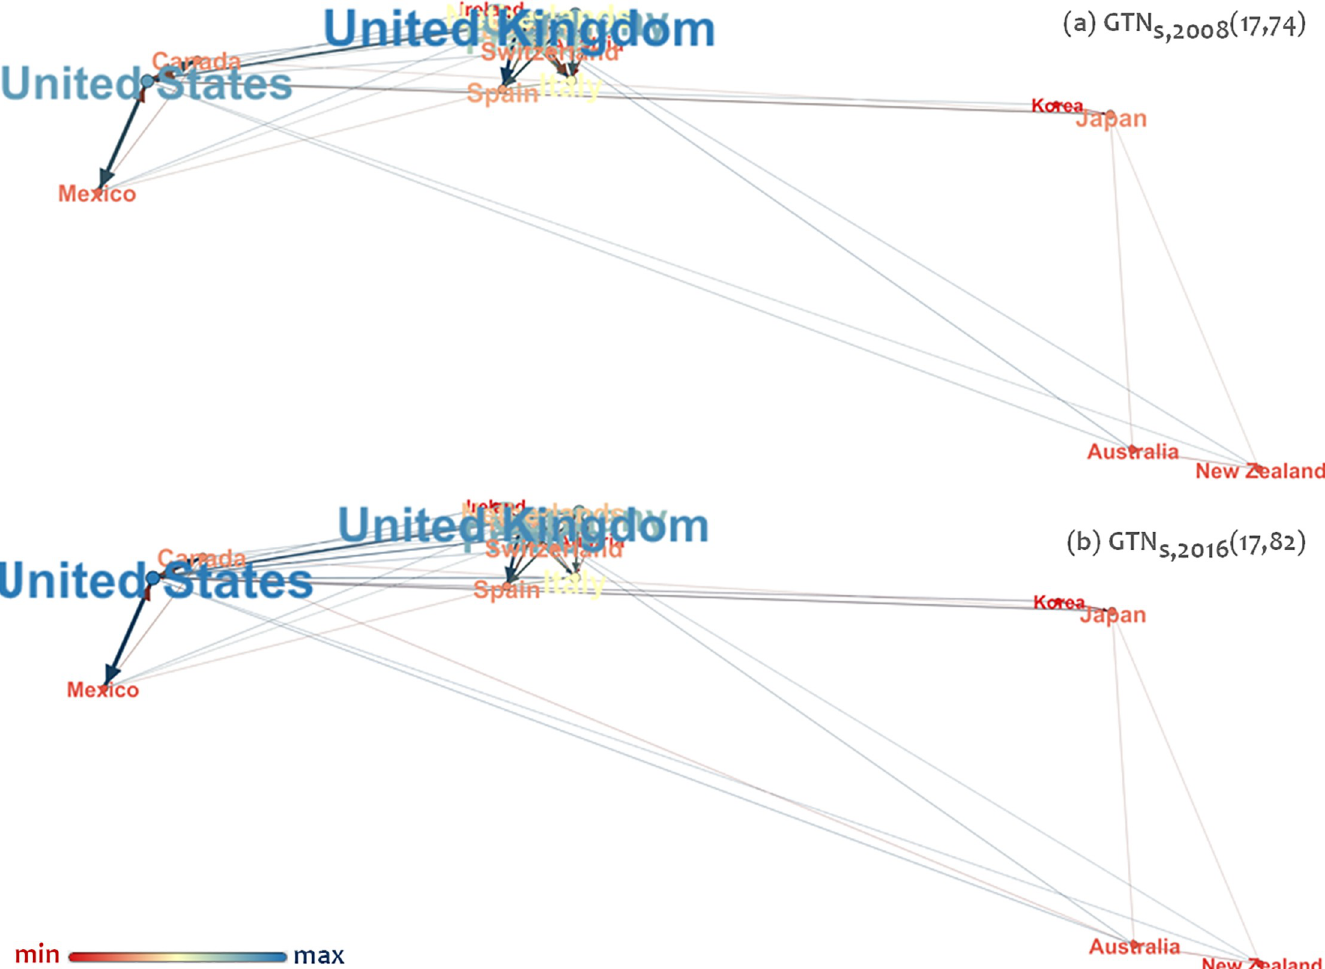
Fig 2. The strongest connected component (GTN s ) of the global inbound tourism network (GTN) [19], shown in geo layout [24] embedding (a) for the year 2008 and (b) for the year 2016. Nodes express tourism destination countries, links express tourists’ arrivals from country (node) i to node j , and node size and coloring are proportional to node degree (undirected). Data extracted from